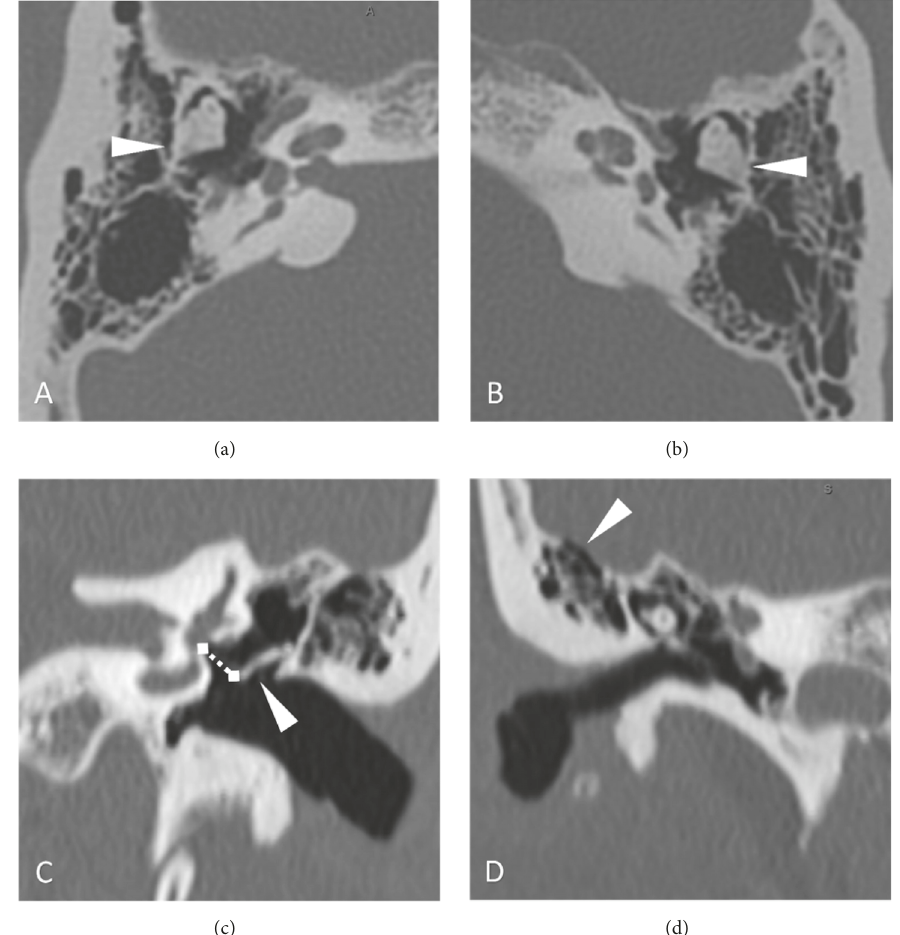
Figure 2: Axial CT bone windows of the temporal bones revealed a markedly enlarged incus with possible fixation in both the right (a) and the left ears (a). Coronal reformats on the left (c) demonstrated an elongated stapes superstructure of approximately 4.8 mm (dashed line) with thickening of the incus long process (arrowhead). On the right (d), this measurement was 4.5 mm. Coronal views of the right ear demonstrated bony dehiscence or thinning in the tegmen mastoideum without meningoencephalic herniation. Similar findings were noted on the